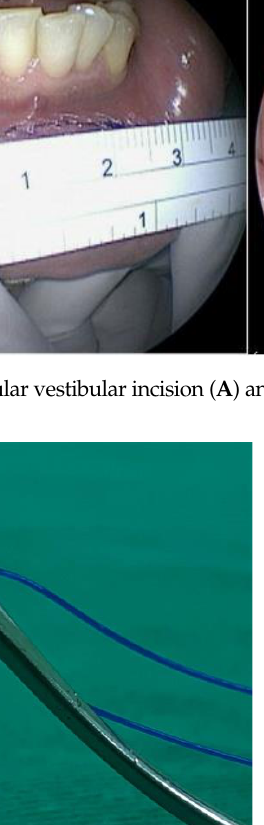
Figure 3. Suture passer attached to a 2-0 interlacing polypropylene suture .